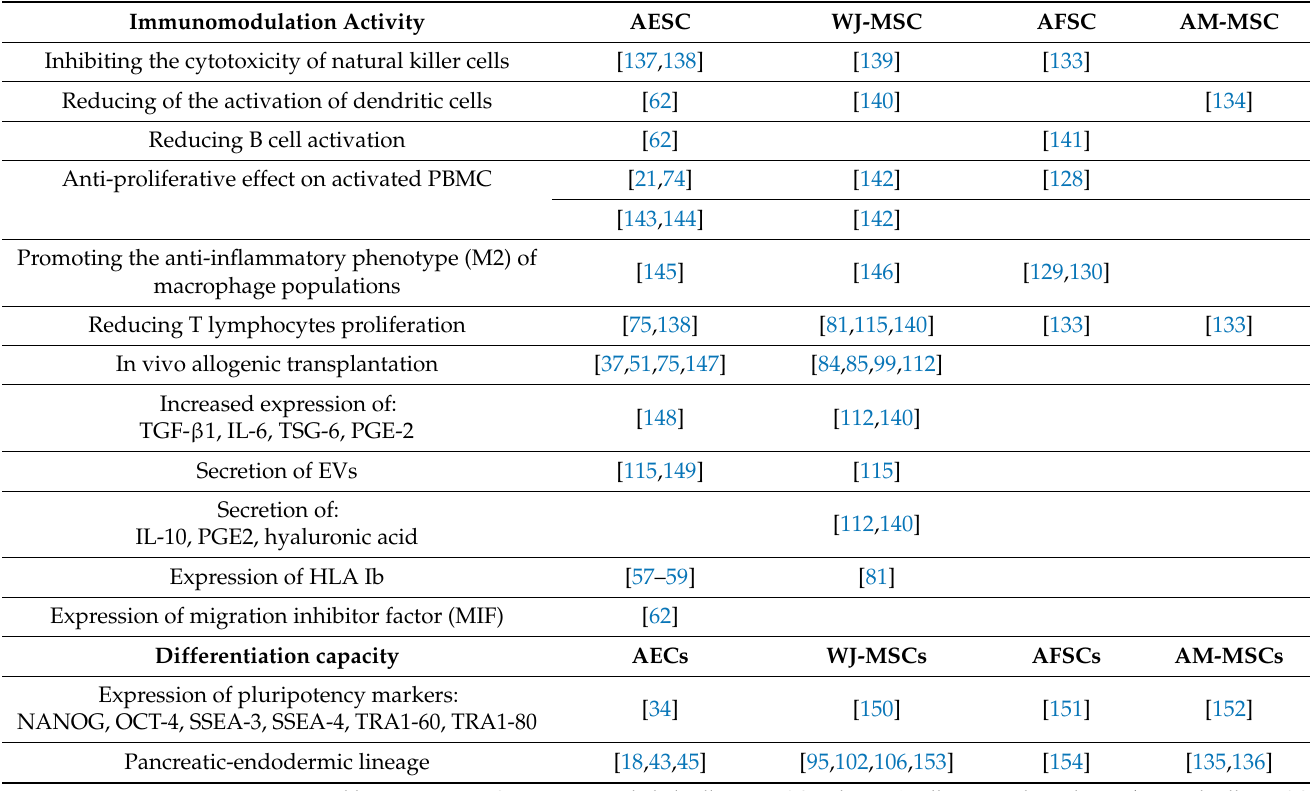
Table 1. The immunomodulatory capacity and differentiation potential of perinatal cells reviewed in this